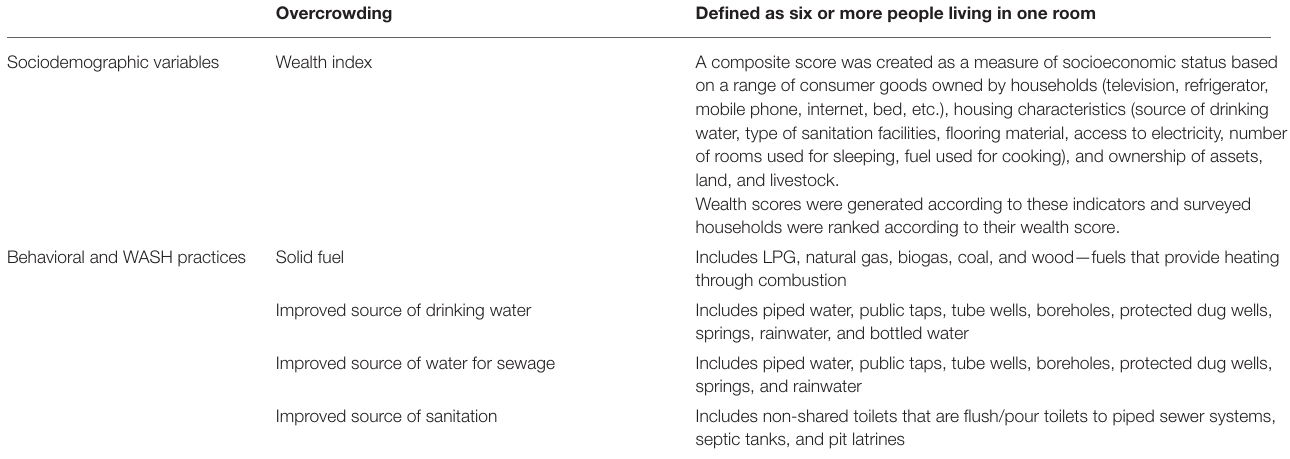
TABLE 1 | Measures for socioeconomic and WASH outcomes. Overcrowding Defined as six or more people living in one